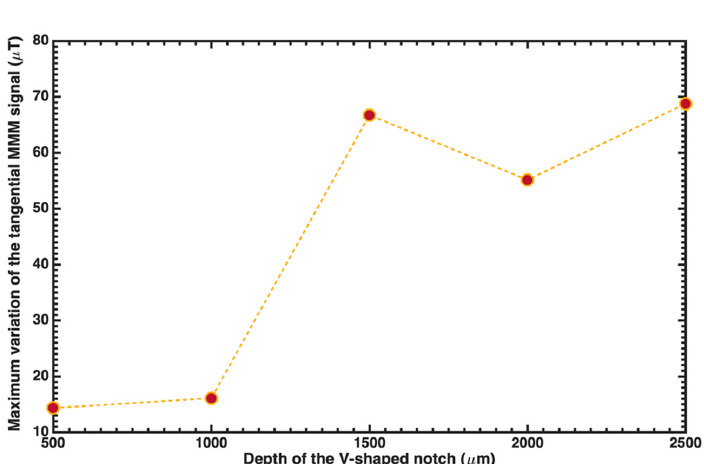
Figure 14. Maximum variation of normal MMM signals versus width of the V-shaped notch of the ASTM-A36 steel pipe. Table 2. Maximum and minimum values of tangential and normal MMM signals around the center and edges of the five V-shaped notches of an ASTM-A36 steel pipe. V-Notch Defect